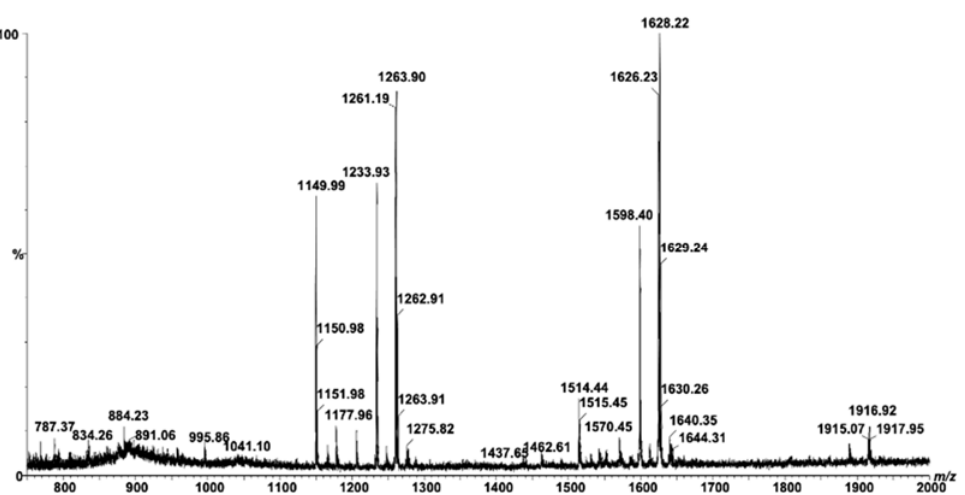
Figure 3. Fully automated ( ‐ )nanoESIchip ‐ QTOF MS of the GG mixture from angioblastic meningi ‐ oma. Sample concentration 2 pmol/L in MeOH; acquisition time 2 min; cone voltage: 30–60 V (re ‐ printed with permission from [152]). Table 2. Proposed composition of single components in the GG mixture from angioblastic menin ‐ gioma specimen as detected by fully automated ( ‐ )nanoESIchip ‐ QTOF MS (reprinted with permis ‐ sion from [152]).